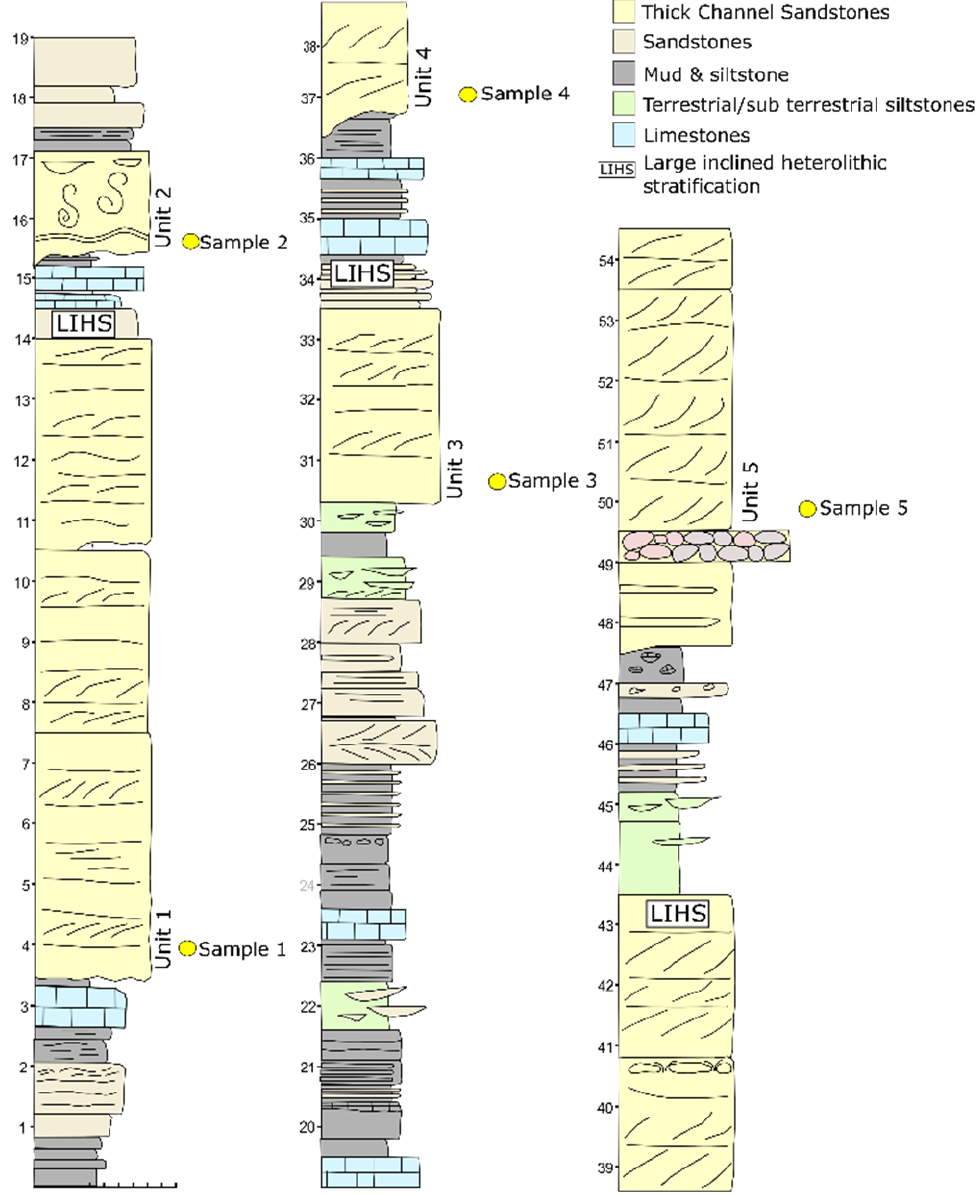
Figure 3. Log of the Mullaghmore Sandstone Formation west of Ballycastle in North Mayo. Sample locations are indicated—these are located in the base of five prominent channel sandstones.